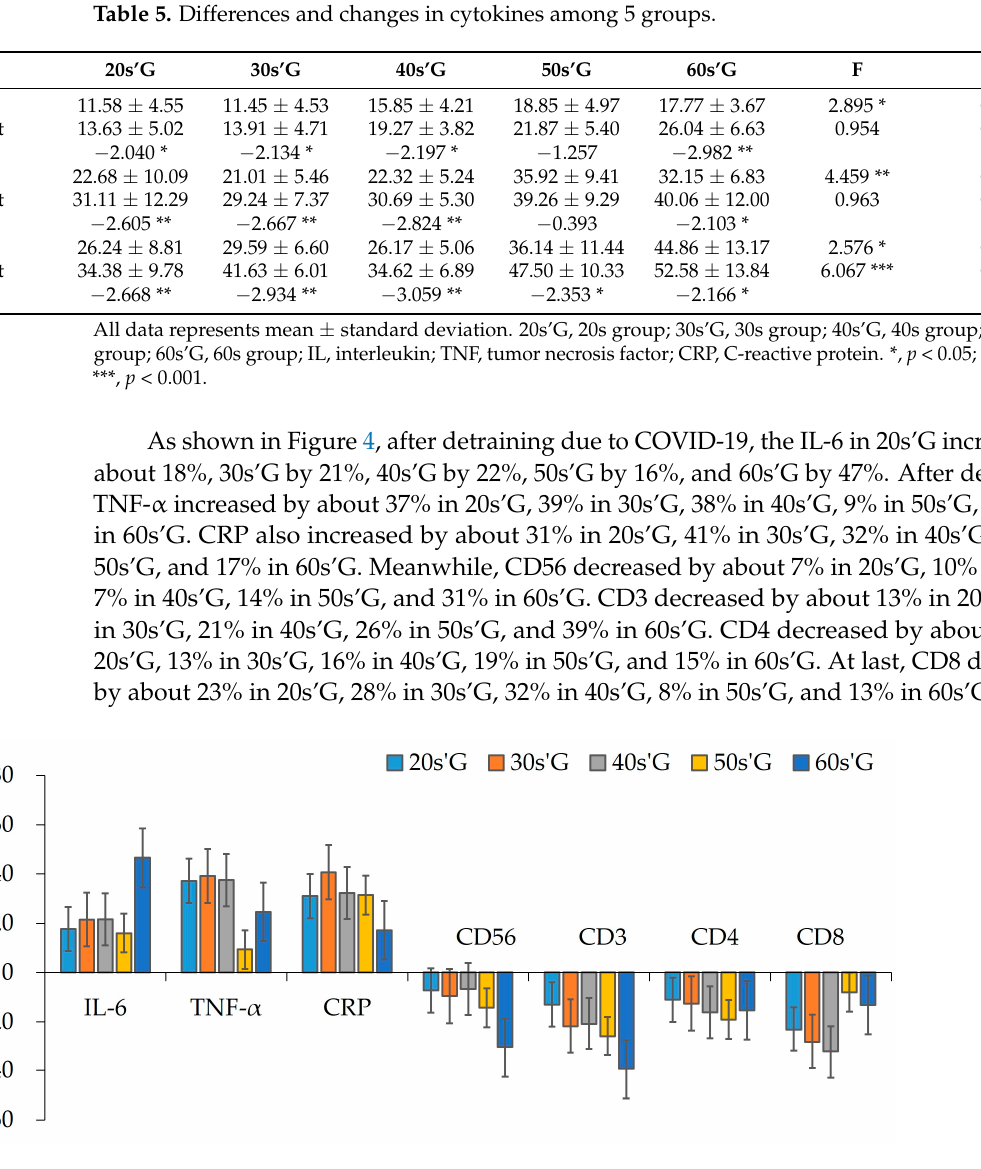
Figure 4. Delta % in cytokines, CRP, and immunocytes among groups after detraining.